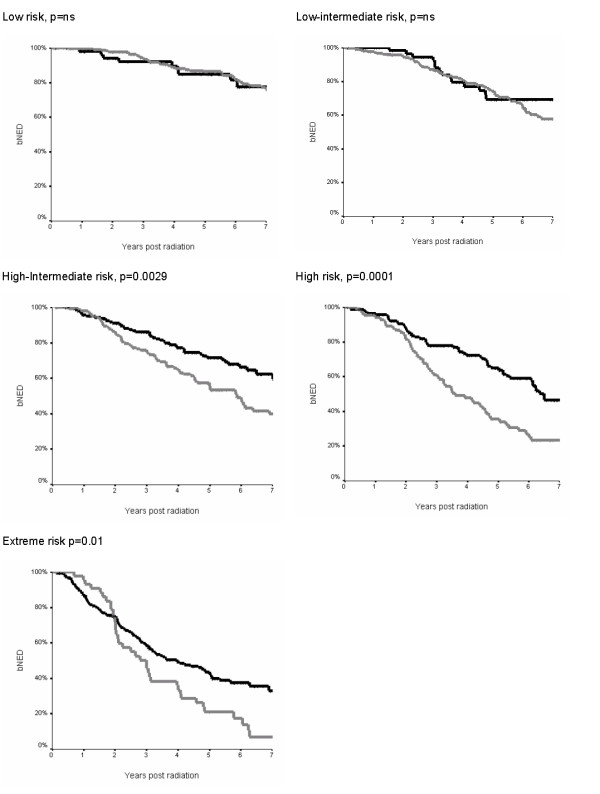
Kaplan Meier curve for bNED (biochemical lack of evidence of disease survival) according to expanded risk group [6]. 5-year bNED rates and hazard ratios are in Table 3. Black lines show combined EBRT and ADT, grey lines EBRT alone. P values refer to the log-rank test.